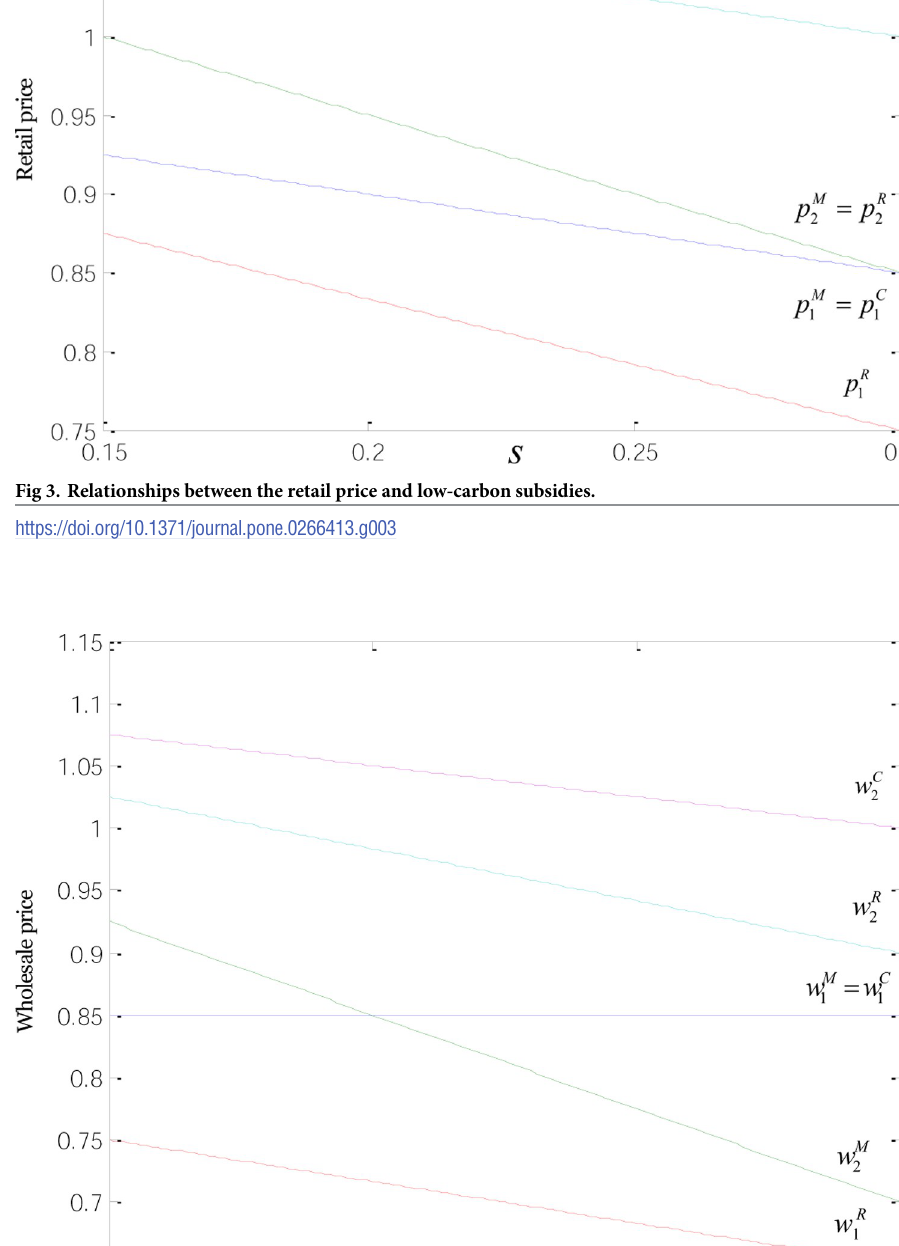
PLOS ONE | https://doi.org/10.1371/journal.pone.0266413 April 1,